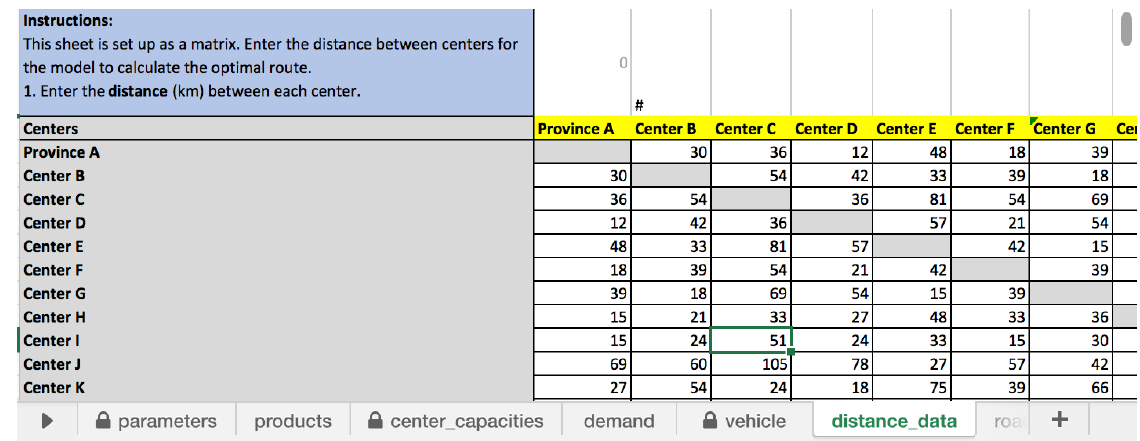
Figure 3. Distance matrix to fill in “distance_data” input